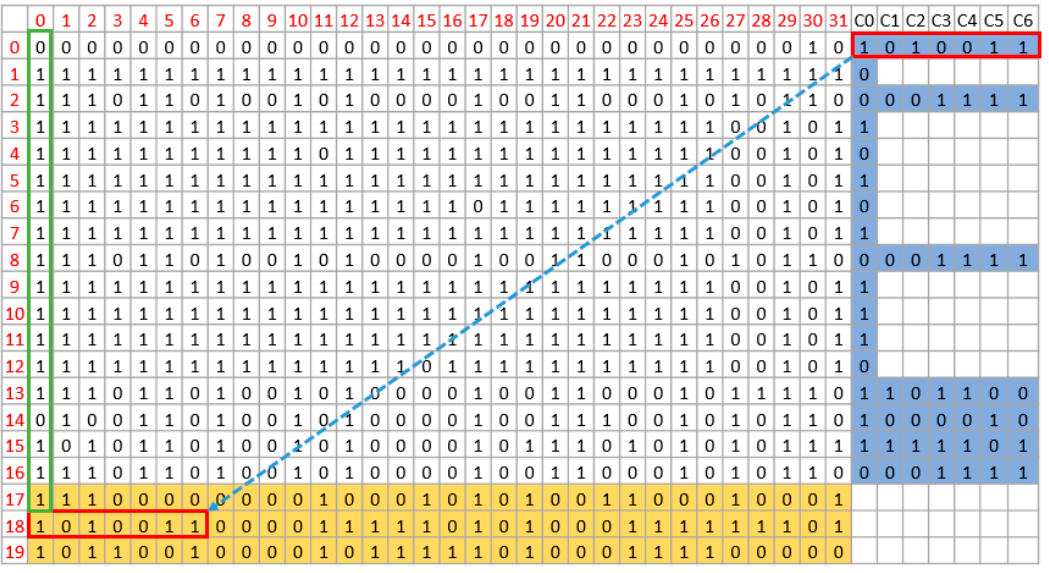
Figure 6. 2D-VLEDC applied in NVM.